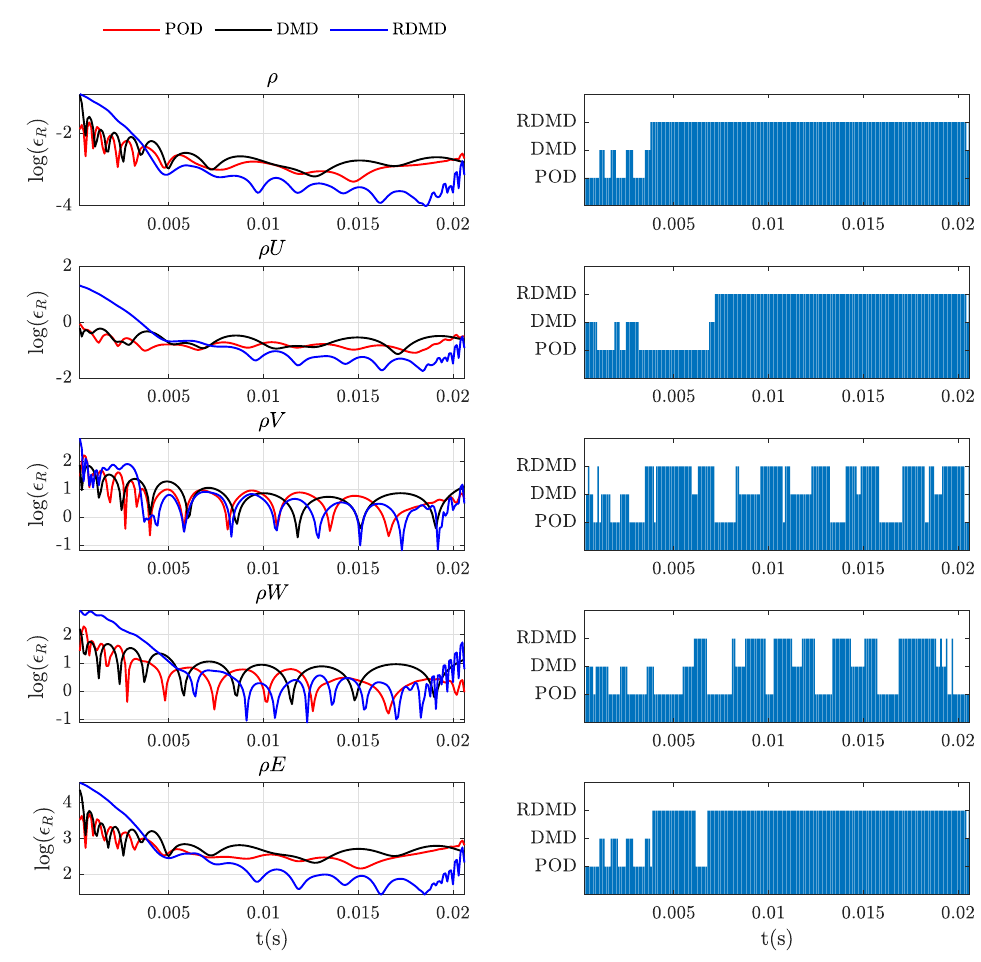
Figure 14. Volume residual evaluation ( left column) and choice of methods ( right columns) for all the conservative variables (excluding turbulence), fixed number of modes N m = 10, delta wing test case.